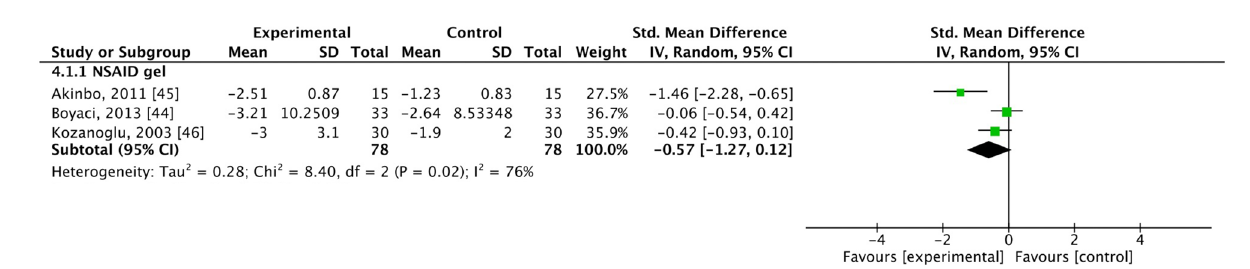
Figure 6. Forest plot for improvement in walk test scores. SD, standard deviation; CI, confidence interval.